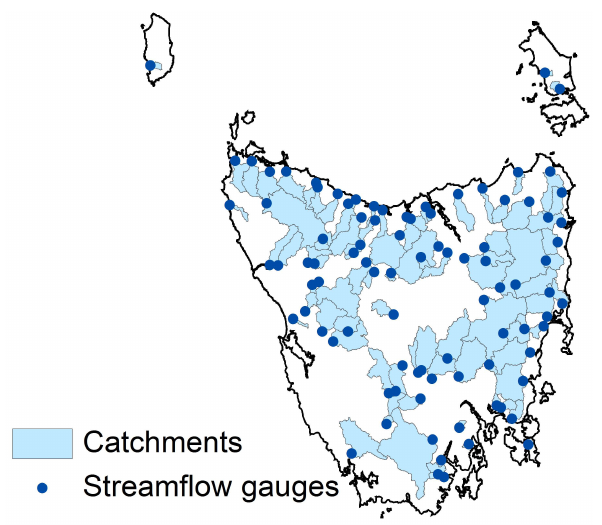
Fig. 5. Catchments and streamflow gauges used to validate hydro- logical model performance.